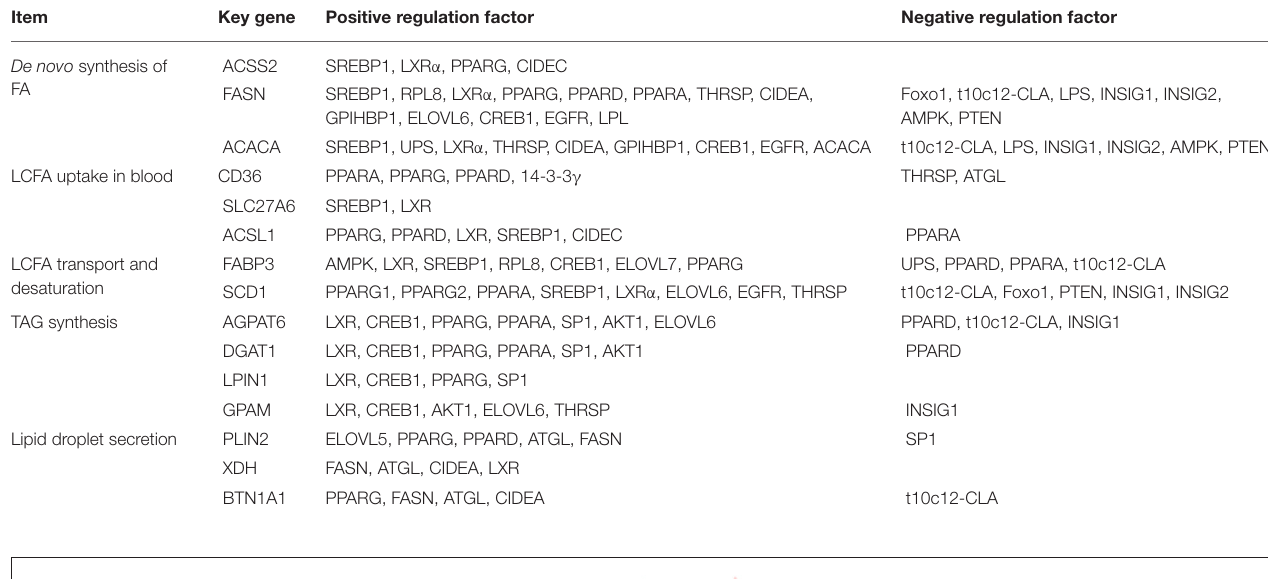
TABLE 1 | Regulatory relationships of key genes for milk fat synthesis in ruminant livestock.